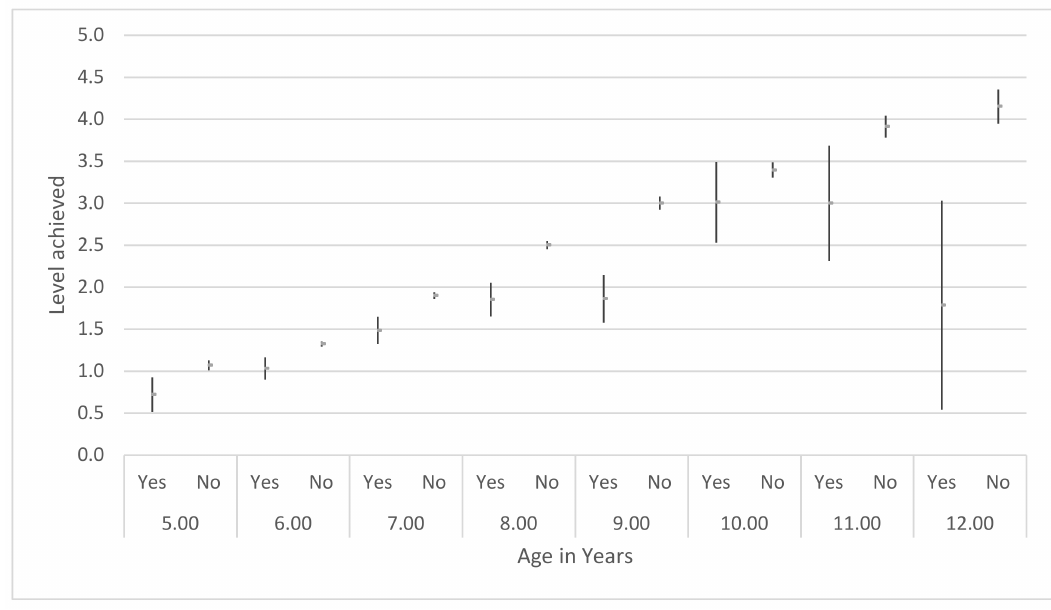
Figure 2. Average level achieved by age in years and negative prior aquatic experience yes /